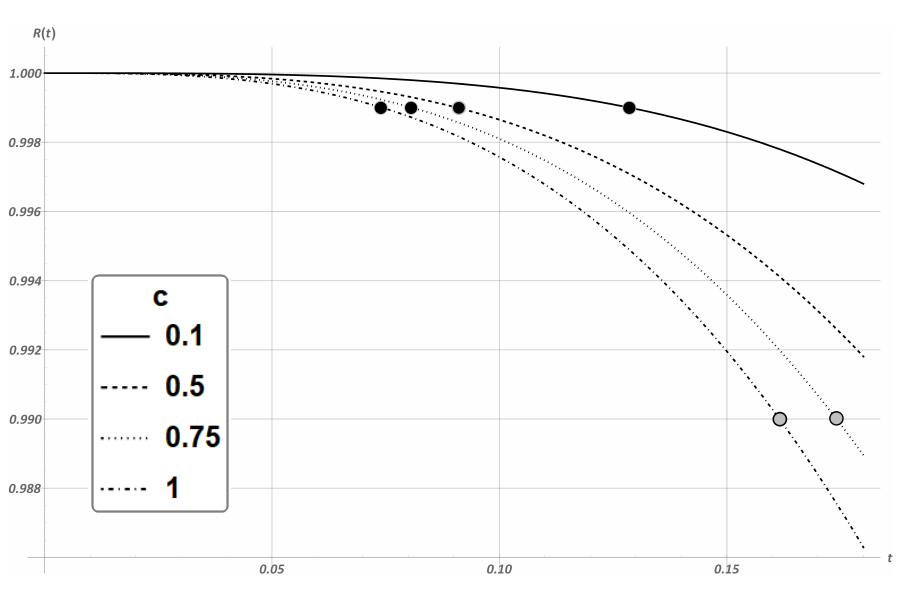
Figure 2. Reliability function with v = 0.5227 and